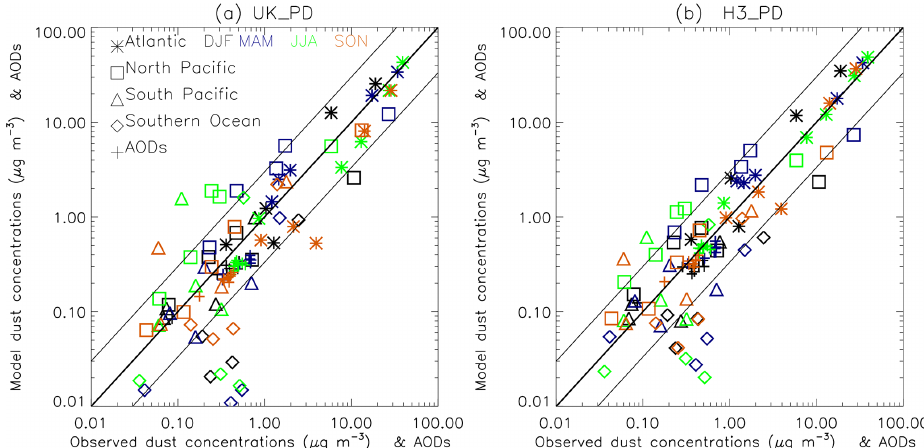
Figure 2. Scatterplots of model versus observational multi-annual seasonal mean concentrations at remote marine locations and AODs in dusty areas for (a) UK_PD and (b) H3_PD. Concentrations are from the University of Miami Network stations at Cape Grim, King George Island, Mawson Station, Palmer Station, Funafuti, Nauru, Norfolk Island, American Samoa, Midway, Oahu, Cheju, Fanning, Enewetak, Barbados, Bermuda, Mace Head, Miami, and Izana. AODs are from AERONET V3 at the stations listed in Fig.